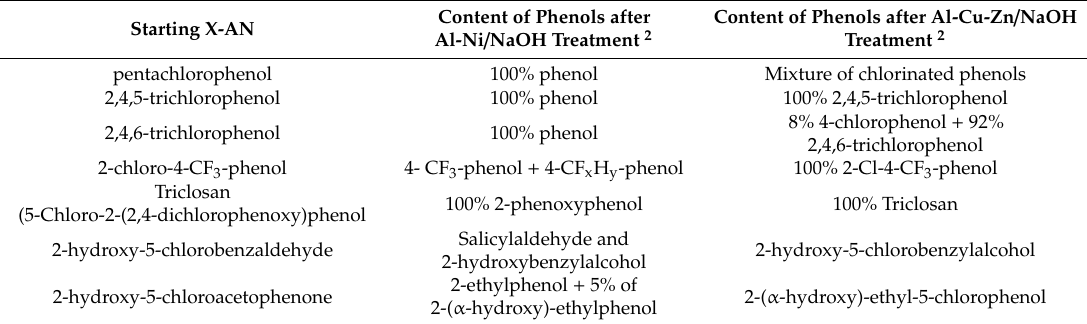
Table 5. Comparison of HDC reactivity of Raney Al-Ni and Devarda’s Al-Cu-Zn alloys toward di ff erent chlorinated phenols 1